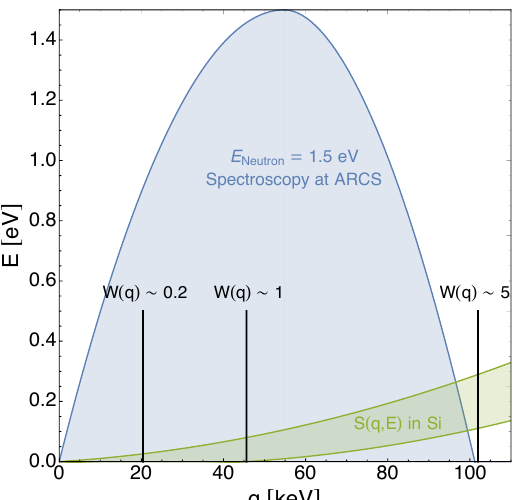
Figure 8. Blue shaded region: the energy-momentum phase space that can be probed kine- matically with a 1.5 eV neutron beam at ARCS for a silicon sample. Green shaded region: the relevant energy-momentum parameter space where the dynamic structure factor in silicon is non- zero. Also shown are the momenta that correspond to the Debye-Waller factor, W ( q ) , equal to 0.2, 1, and